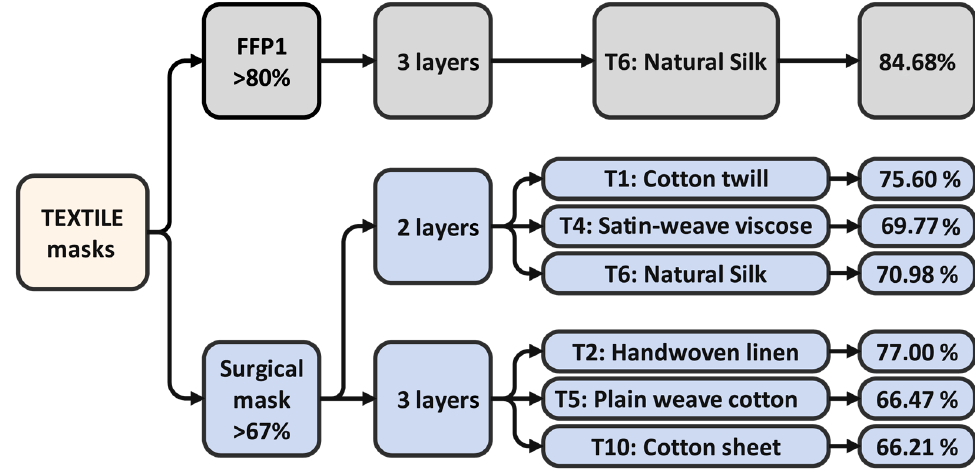
Figure 7. Recommendation for applications with given filtration efficiencies.